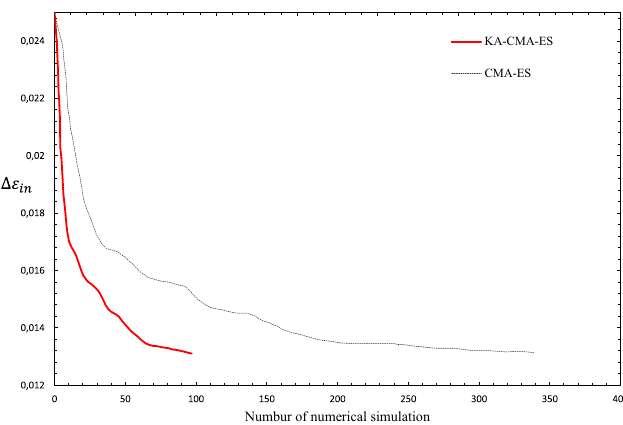
Fig. 12. Average plot of D e in versus number of numerical